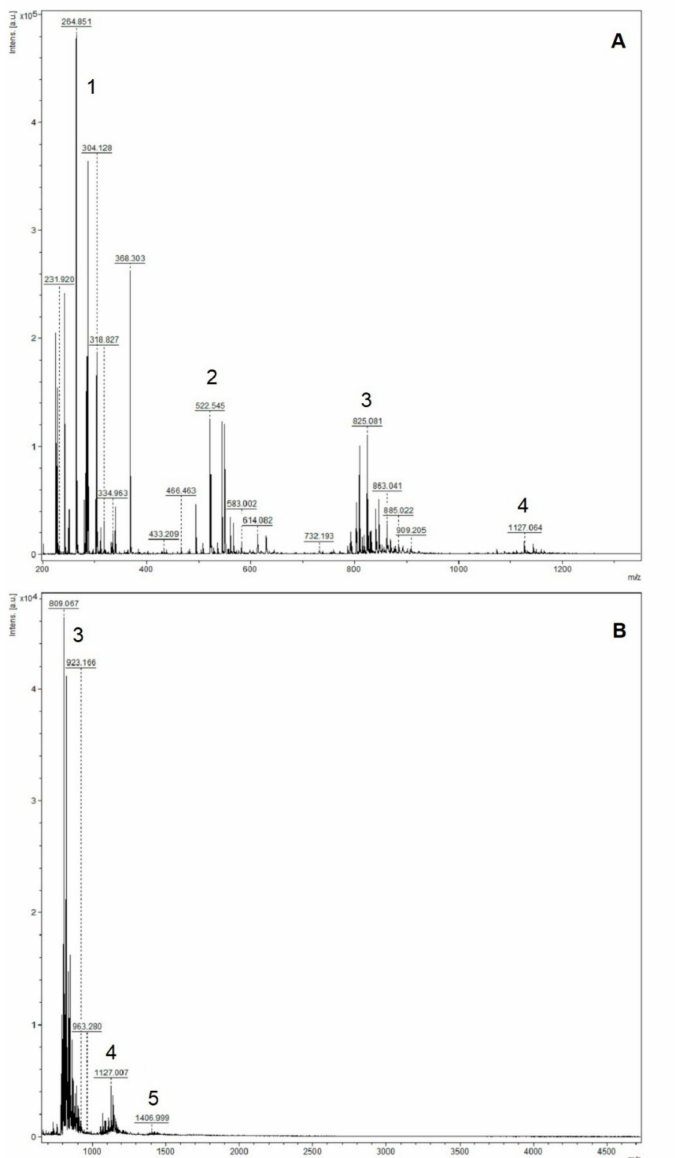
Figure4. MALDI-TOFspectraoftheinsoluble-boundpolyphenolfromguaranapowder. ( A )200–1400Da. 1: Monomers peaks cluster; 2: Dimers peaks cluster; 3: Trimer peaks cluster; 4: Tetramer peaks cluster. ( B ) 700–4700 Da. 5: Pentamers peaks